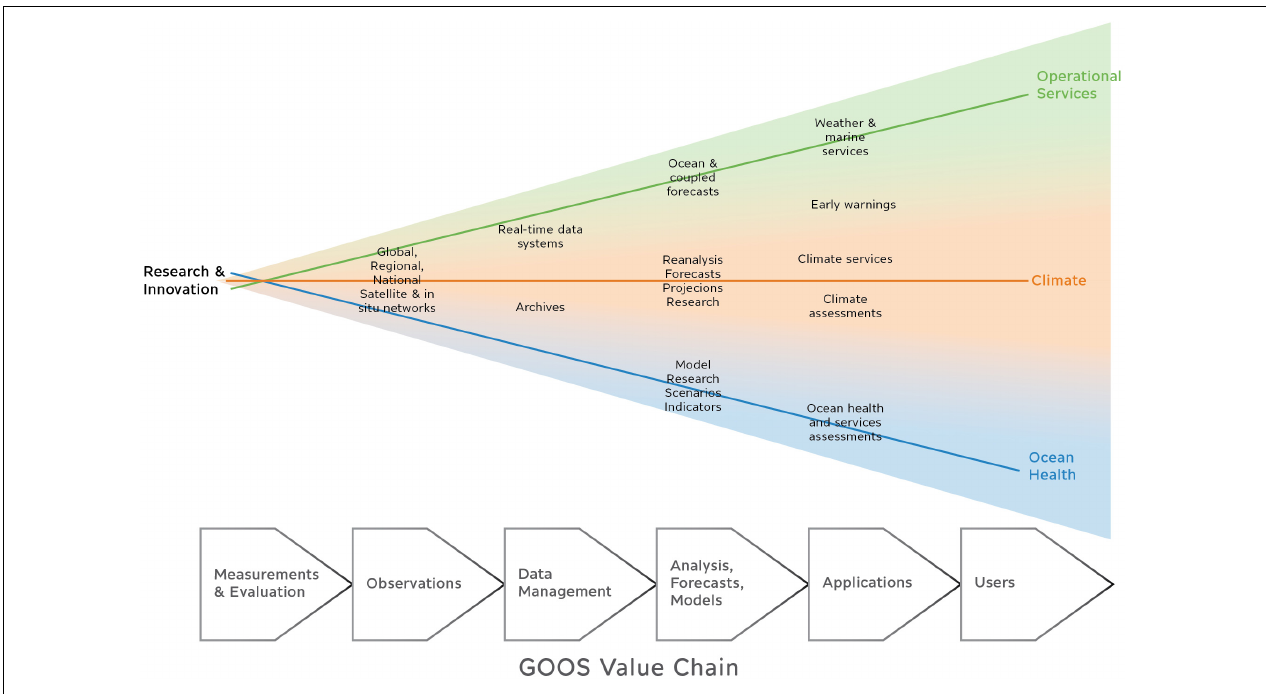
FIGURE 5 | GOOS value chain and associated activities and